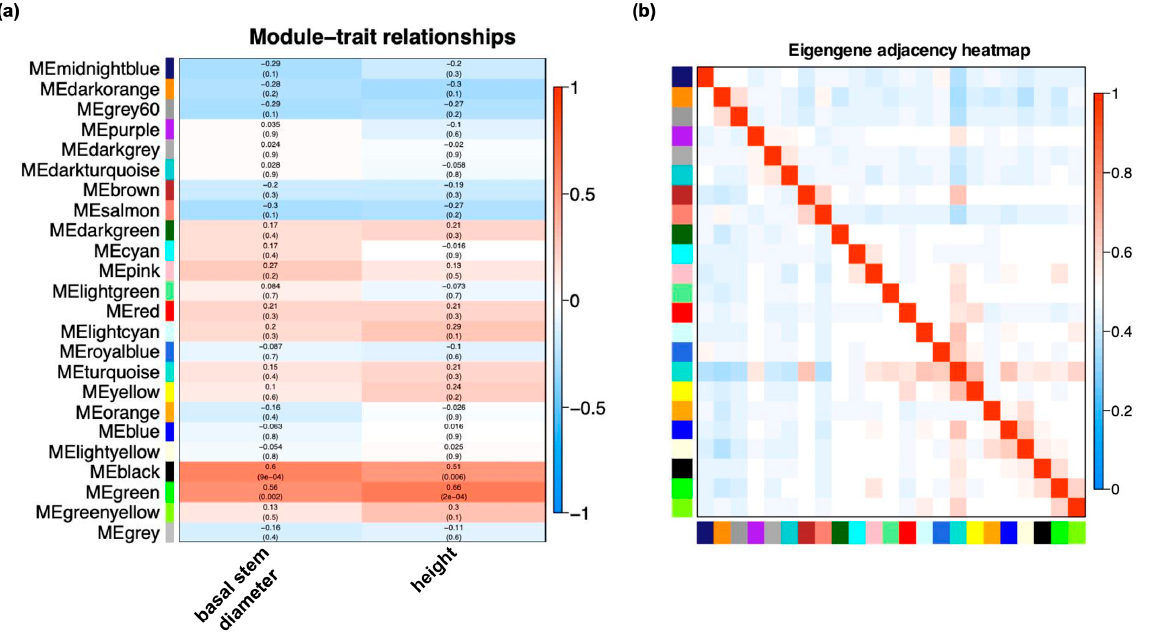
Figure 5. WGCNA revealed the modules highly related to basal stem diameters or heights. ( a ) Module–trait relationship. Each row corresponds to a module, while each column corresponds to the growth trait. Each cell contains a corresponding correlation. ( b ) The heatmap of connectivity of eigengenes.